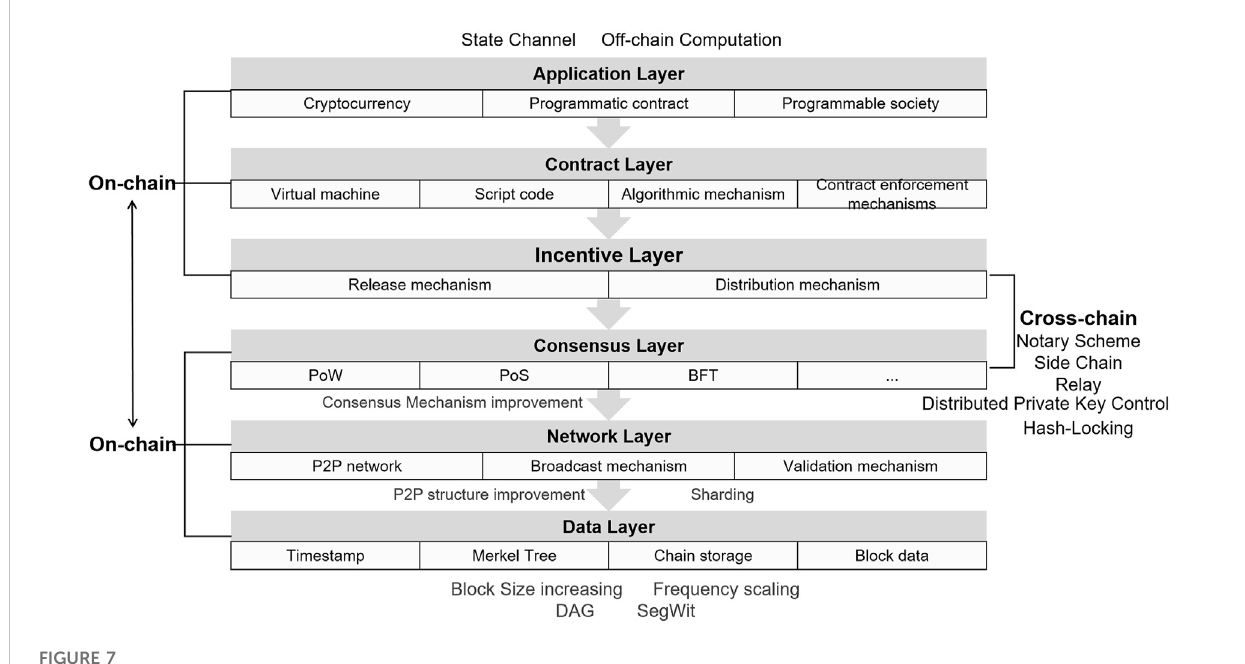
FIGURE 7 Blockchain architecture